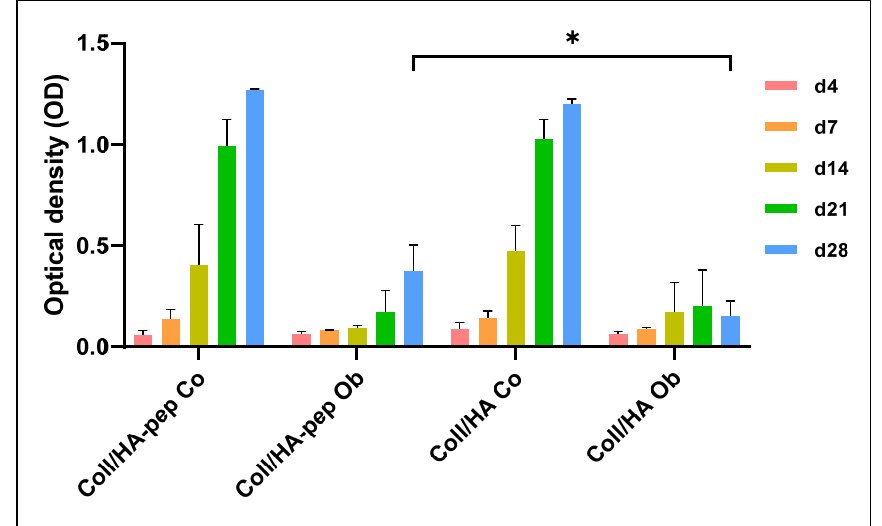
Figure 8. JPC proliferation within collagen/HA (1:2) composites. Collagen/HA composites in a ratio of 1:2 were prepared with (-pep) or without E7 BMP-2 peptides. JPCs were cultured within the composites under normal (Co) and osteogenic (Ob) conditions for 4–28 days (at least three independent experiments). Metabolic activities after these time points are illustrated. * p < 0.05.